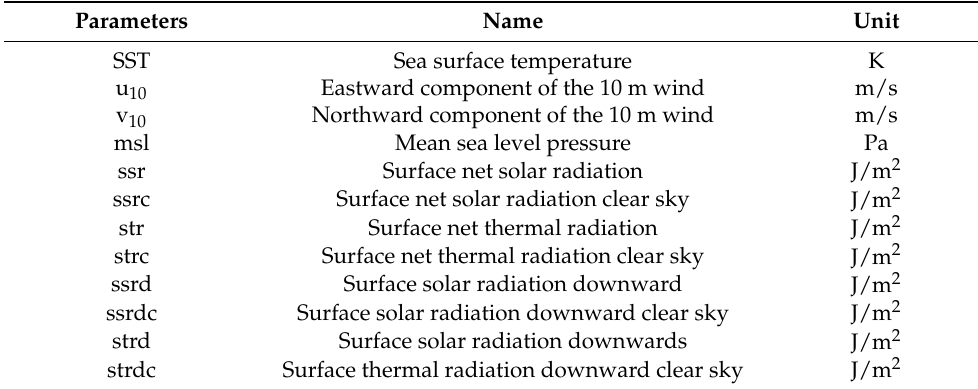
Table 2. Variables affecting SST distribution and variation.